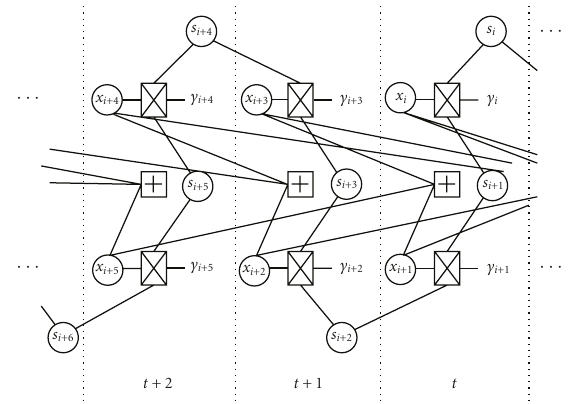
Figure 6: Joint factor graph for an LDPC-CC decoder over a Markov channel. The Markov model wraps around the LDPC-CC factor